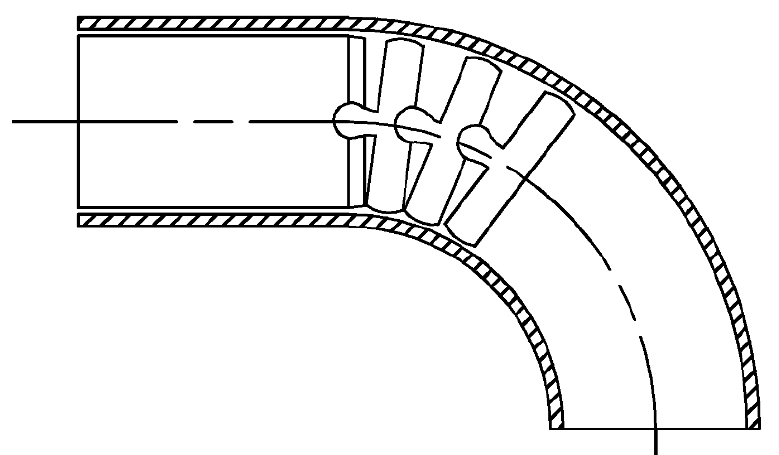
Figure 1. Ball mandrel.